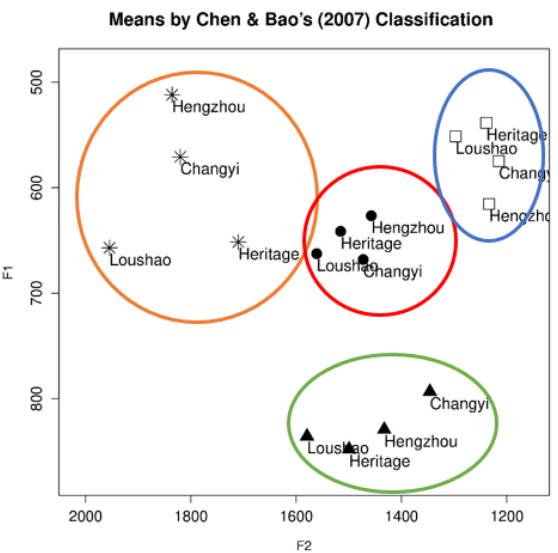
Figure 10. Mean F1-F2 by affiliation in Chen and Bao (2007), incl. heritage speakers. Figure 10. Mean F1‑F2 by affiliation in Chen and Bao (2007), incl. heritage speakers. In Figure 10 the different shapes, as well as the colored circles, represent different vowel qualities identified in the sample. The star represents the ‘front’ vowel quality (ap‑ proaching [e] or [ E ]); the filled dot represents the central quality (approaching [ә]); the empty square represents the back quality (approaching [ 7 ]); the filled triangle represents the low quality (approaching [a]). Figure 10, based on the work of Chen and Bao (2007), shows that HM vowels do not display any particular taxonomic clustering; this can be seen from the fact that all groupings have both mid‑front and mid‑central qualities, and in fact have all four qualities represented. However, the fact that all of the Chen and Bao group‑ ings have a mix of qualities is in line with the status of Xiang as transitional between larger northern and southern Sinitic groups, which more clearly pattern one way or the